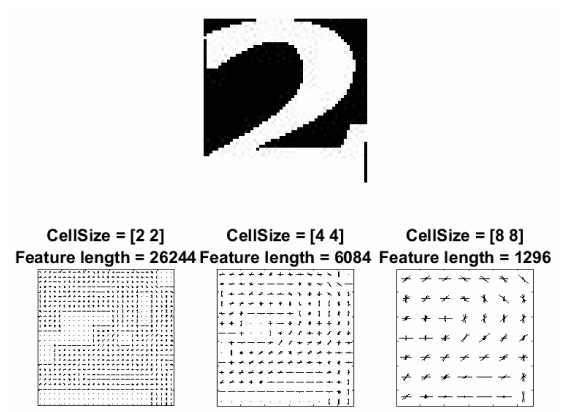
Figure 5. Visualisation of dimension in the histogram of oriented gradients (HOG) feature vector.